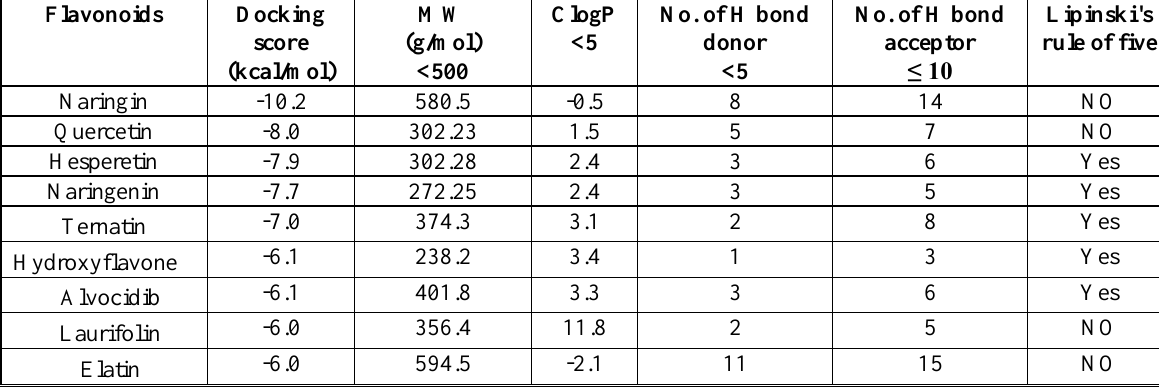
Table 1. The docking score (kcal/mol), MW, CLogP, No. of H bond donor, No. of H bond acceptor, and Lipinski’s rule of five for